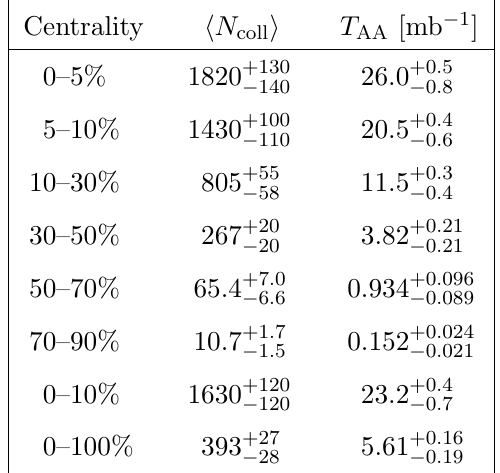
p s NN = 5 : 02 TeV PbPb collisions